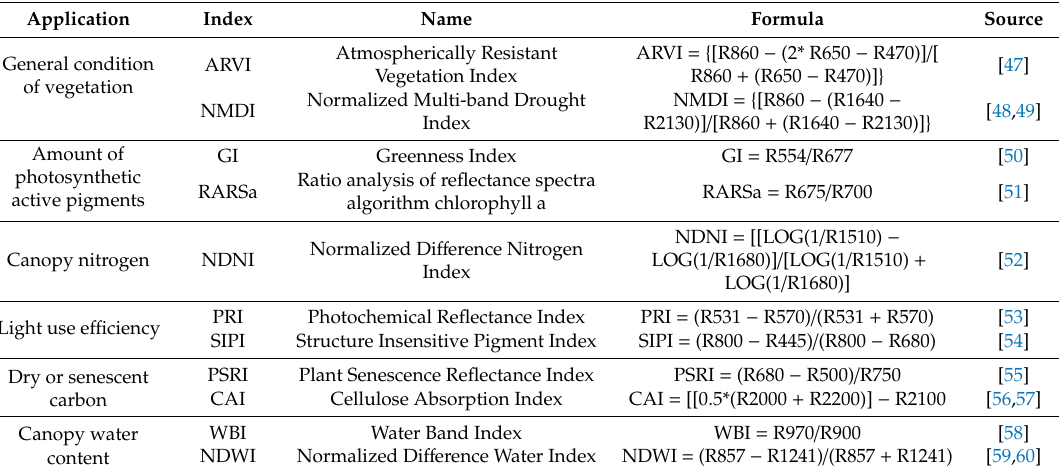
Table 1. Used remote sensing